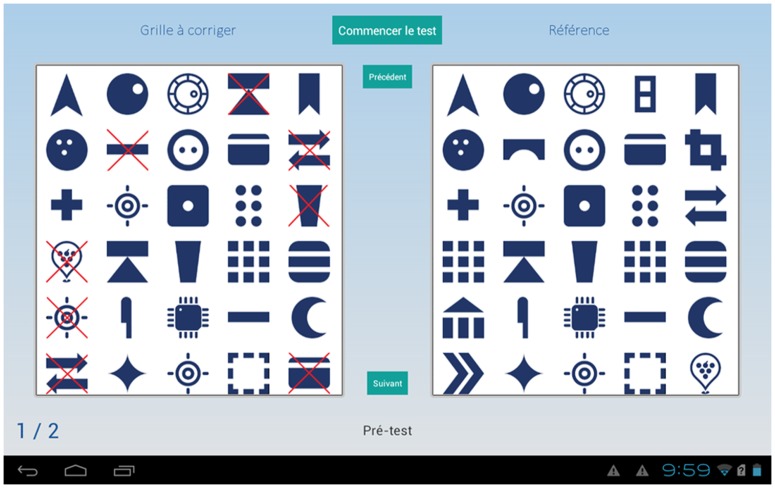
Table-based cancellation test (e-CT).